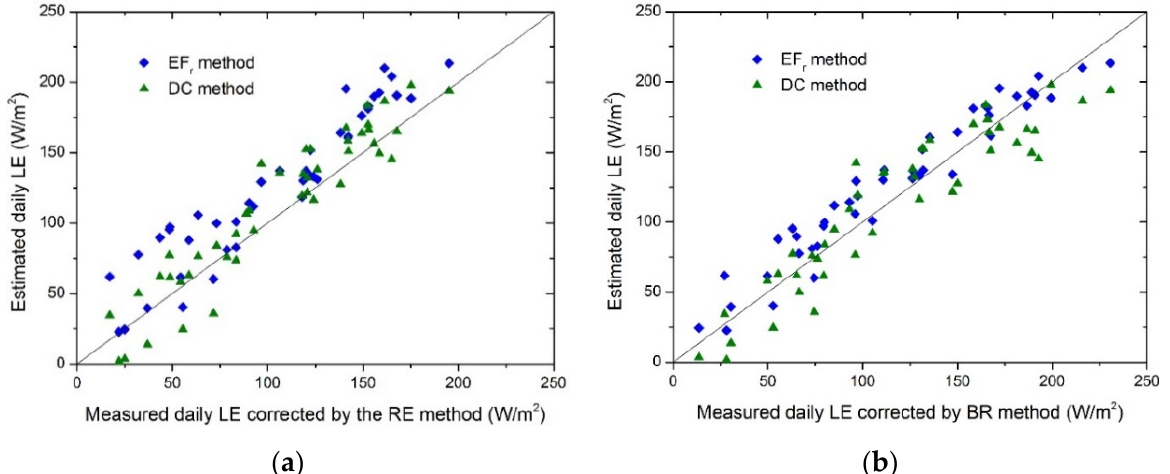
Figure 5. Validations of daily ET estimations calculated by the DC method and temporal upscaled by the constant EFr method against with corrected EC flux measurements by ( a ) the RE scheme and ( b ) the BR scheme.